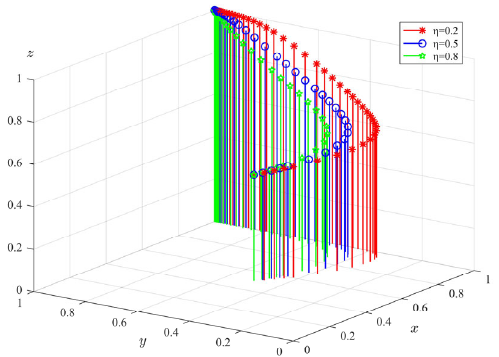
Figure 8. The impact of penalty coefficient ( η ) on the evolution of tripartite behavior.